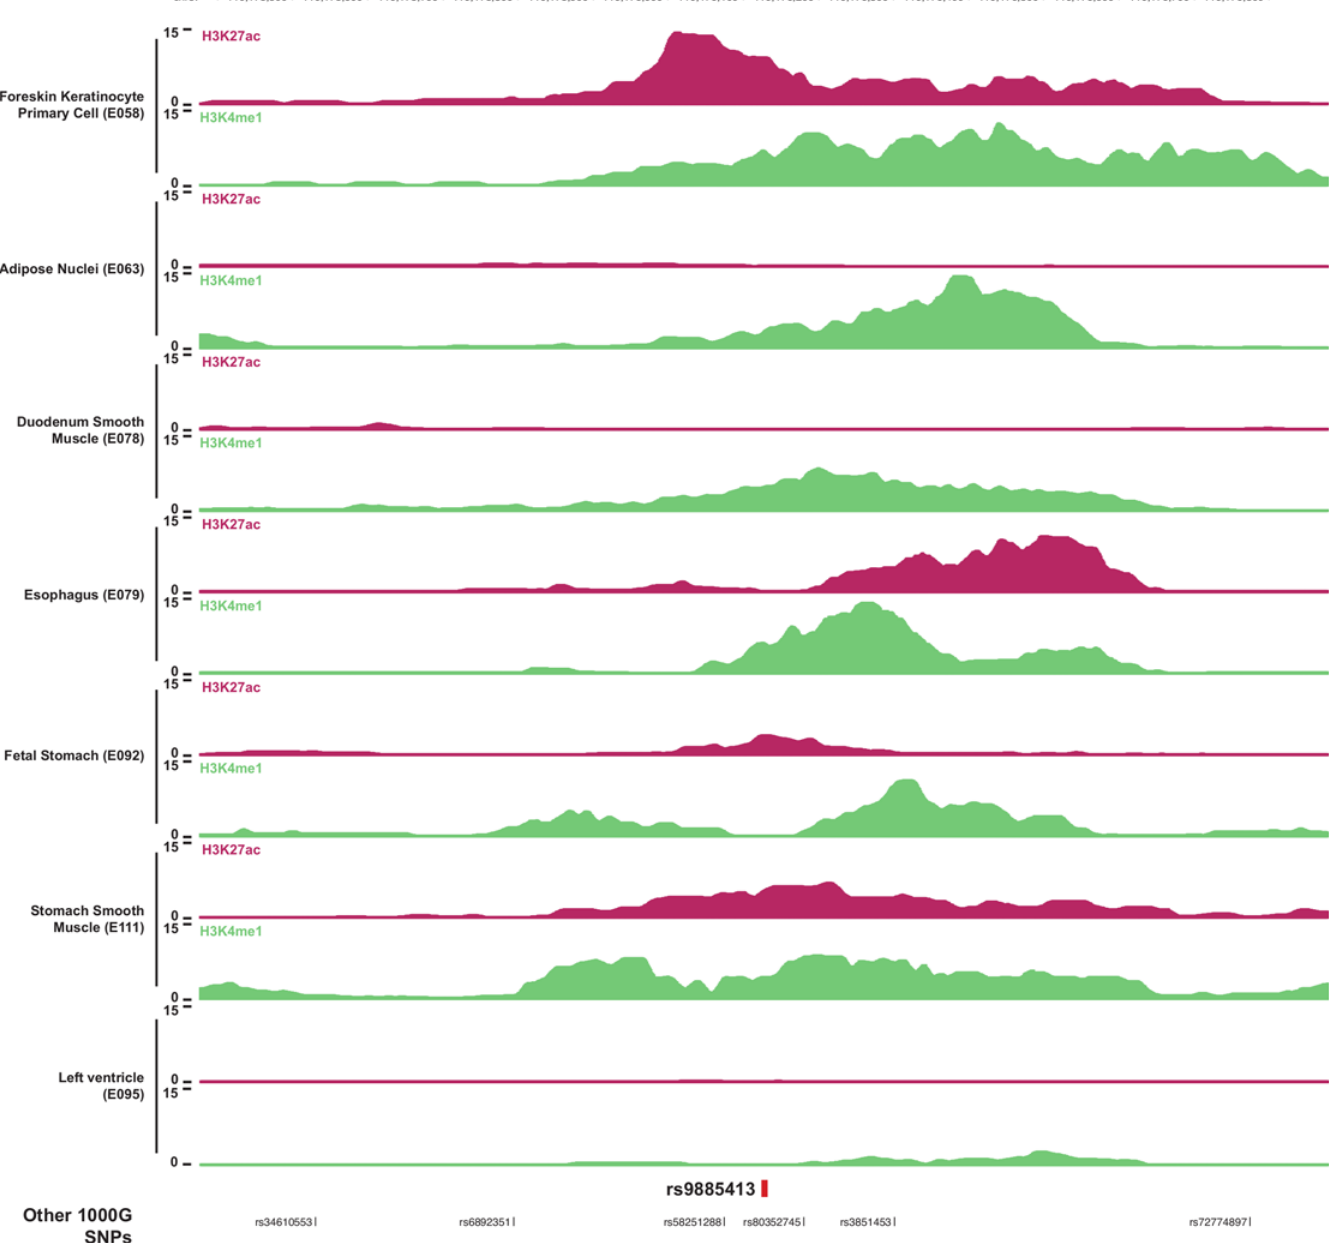
Fig 2. Epigenomic marks indicating enhancer activity at the 5q22 locus. Histone marks in samples from the ROADMAP Epigenomics Project at the enhancer overlapping the lead SNP rs9885413 in heart tissue (left ventricle) and in tissues with evidence of an active enhancer at the locus. Histone marks are monomethylation (H3K4Me1) of the fourth residue (lysine) and acetylation of the 27th residue (H3K27Ac) of histone H3. Positions refer to NCBI build